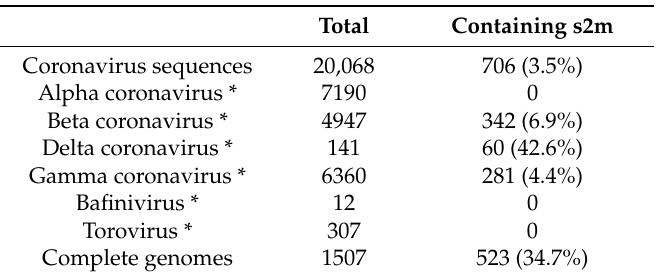
Table 1. Coronavirus sequences in